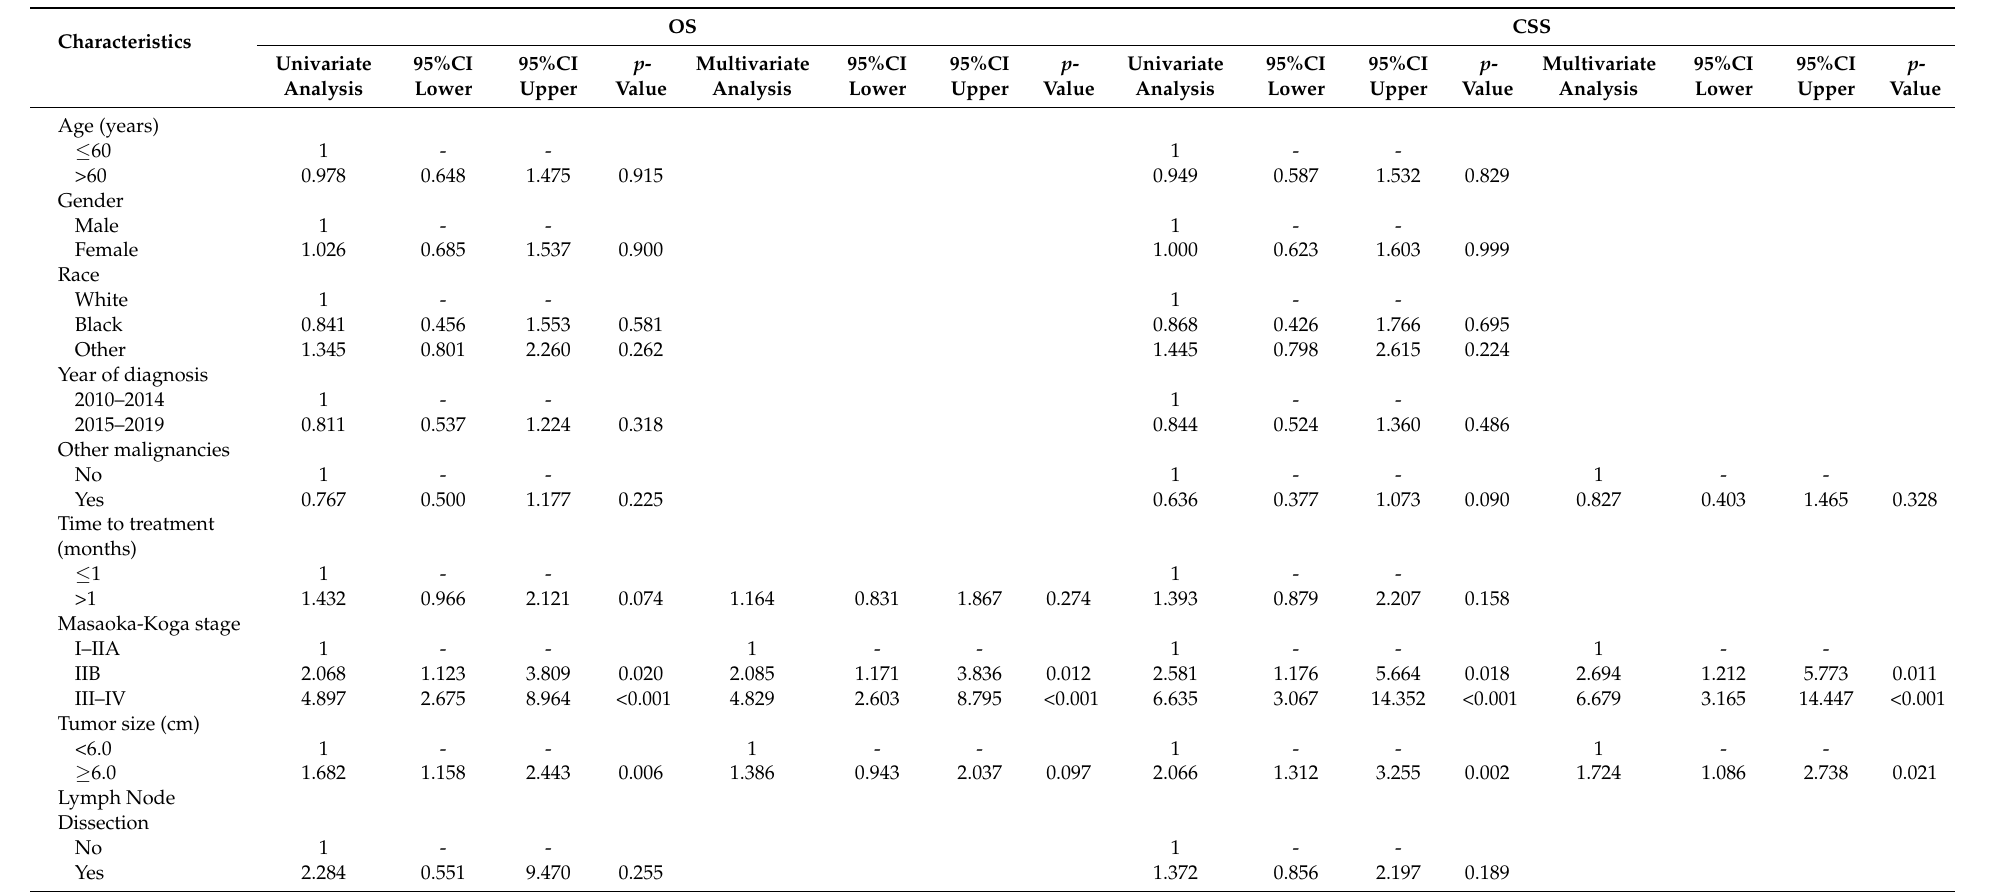
Table 5. Univariate and Multivariate Cox regression analysis of clinical characteristics for overall survival and cancer-specific survival rate in thymic carcinoma patients in the matched